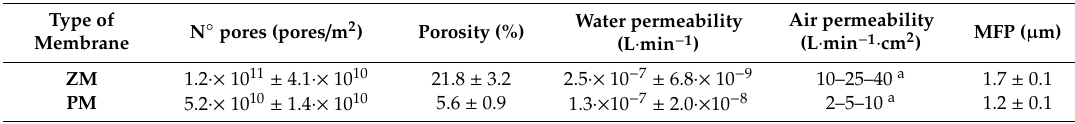
Table 2. Values of number of pores, porosity, water permeability, and MFP (mean flow pore) of ZM and PM membranes in experiment 1.